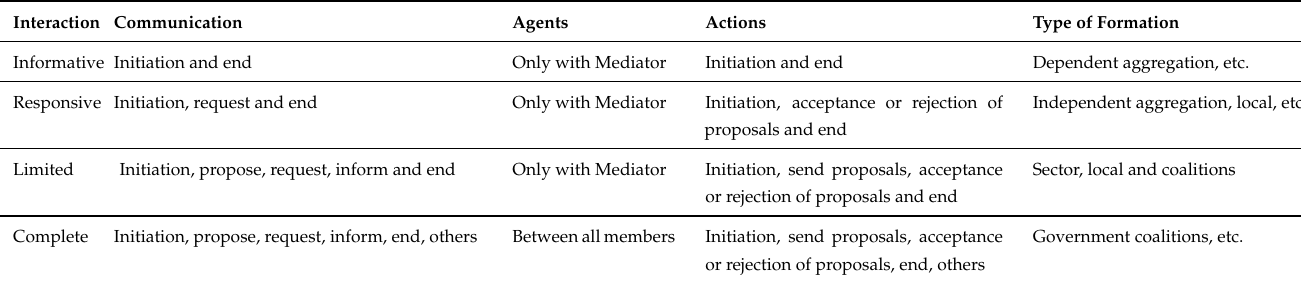
Table 2. Type of interaction in the